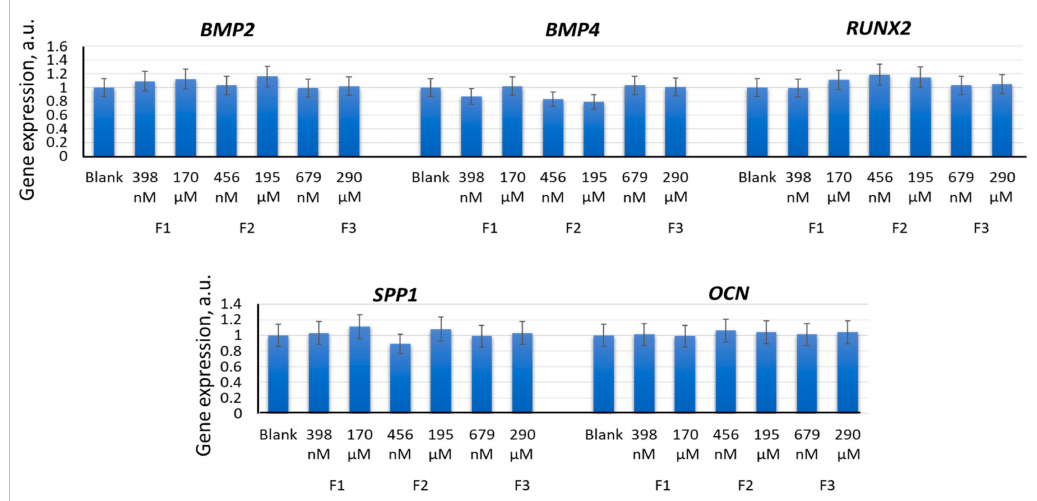
Figure 9. The effect of F1, F2, and F3 on the osteogenic differentiation genes; the concentrations and exposition times are shown in the figure. The gene RNA amount was the mean value for three experiments related to the blank; the TBP gene was used as an internal reference gene. In blank experiments, cells were incubated without the fullerenes.